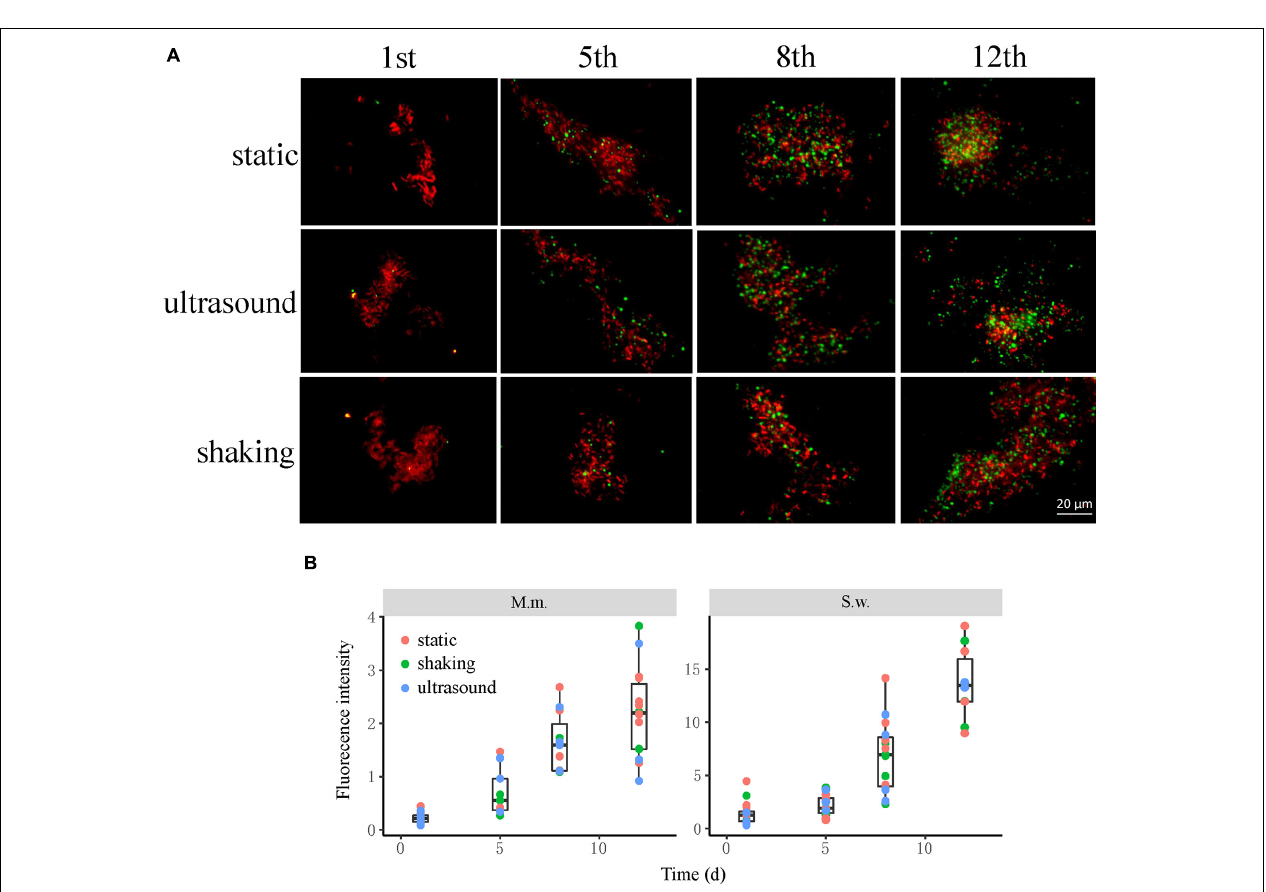
FIGURE 5 | The influence of physical disturbance on the formation and maturation of syntrophic aggregates in the Syntrophomonas – Methanococcus coculture. Fluorescence in situ hybridization (FISH) observations (A) were made at different timepoints over the incubation. Oligonucleotide probes specific for bacteria (Cy3-labeled EUB338mix probes in red) and archaea (fluorescein isothiocyanate (FITC)-labeled ARC915 probe in green) were used. Shown are the representative images of more than 10 observations in each sample. The box plots (B) shown are the fluorescence intensity of the individual populations estimated using the ImageJ software. The center line denotes the median, the boxes cover the 25th and 75th percentiles, and the whiskers extend to the all data points. See Figure 3 for more explanation about the incubation and treatments.